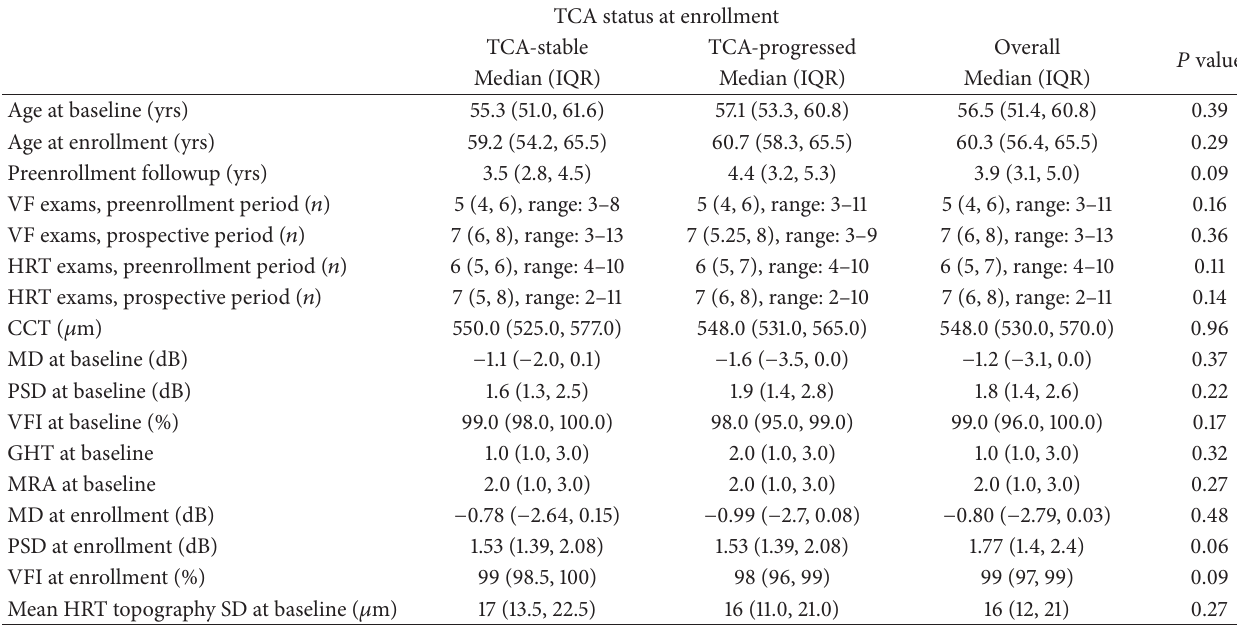
Table 2: Comparison of baseline and enrollment descriptive characteristics, in TCA-progressed (based on HRT TCA status at enrollment) and TCA-stable